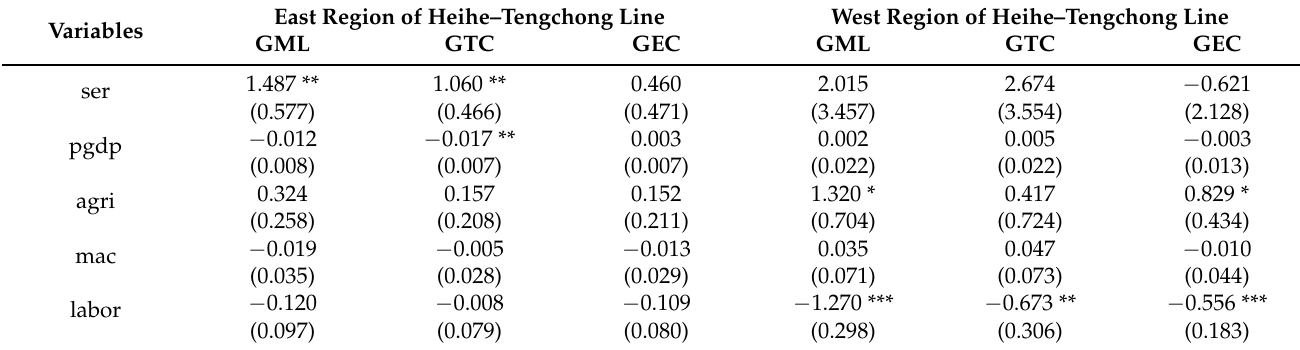
Table 6. Heterogeneity analysis based on Heihe–Tengchong line.